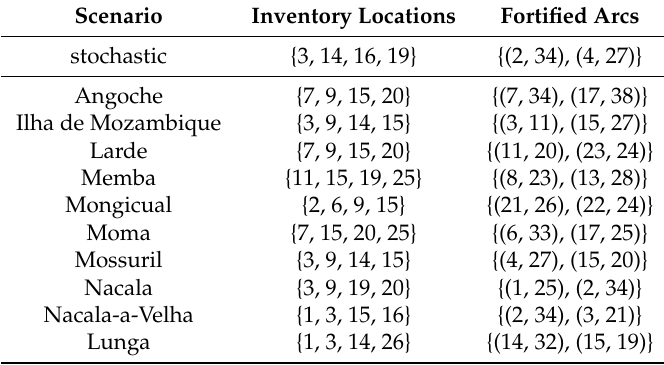
Table 4. Solution comparison between the stochastic and the deterministic model, for ( P , Q ) = ( 4,2 ) .